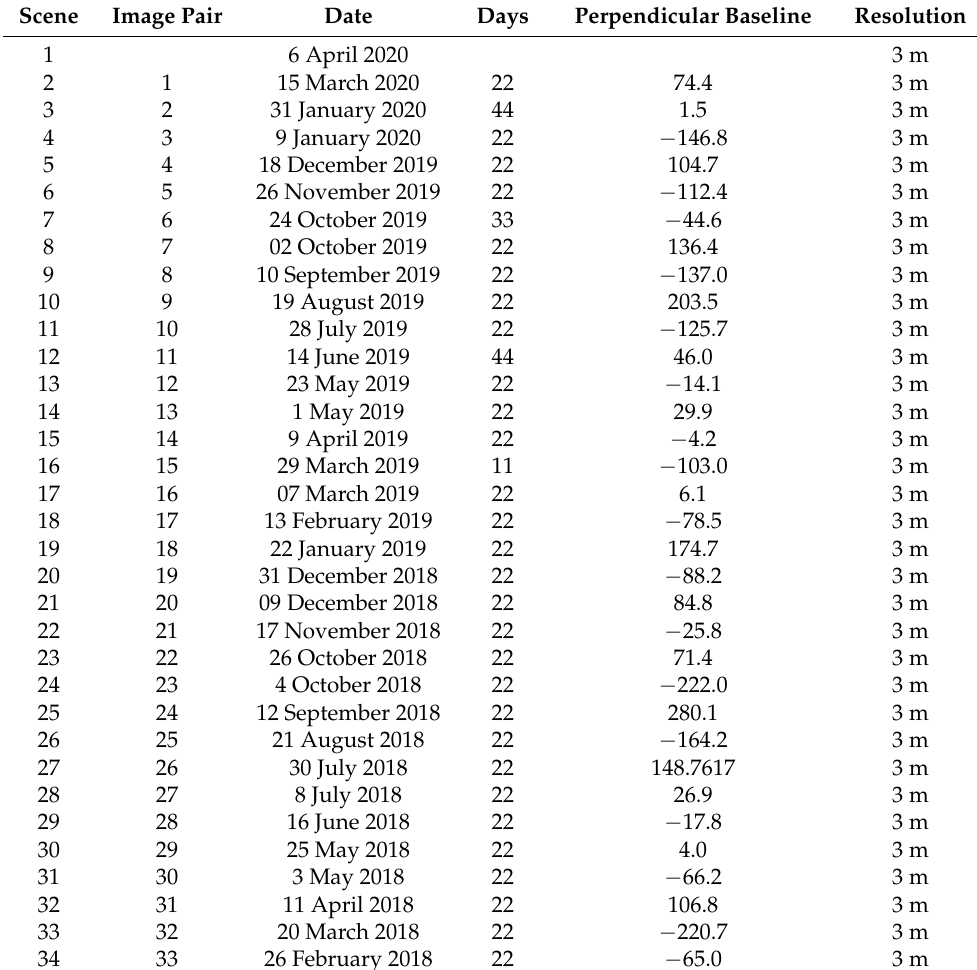
Table 1. TSX SAR offset tracking displacement maps time intervals, perpendicular baseline, and